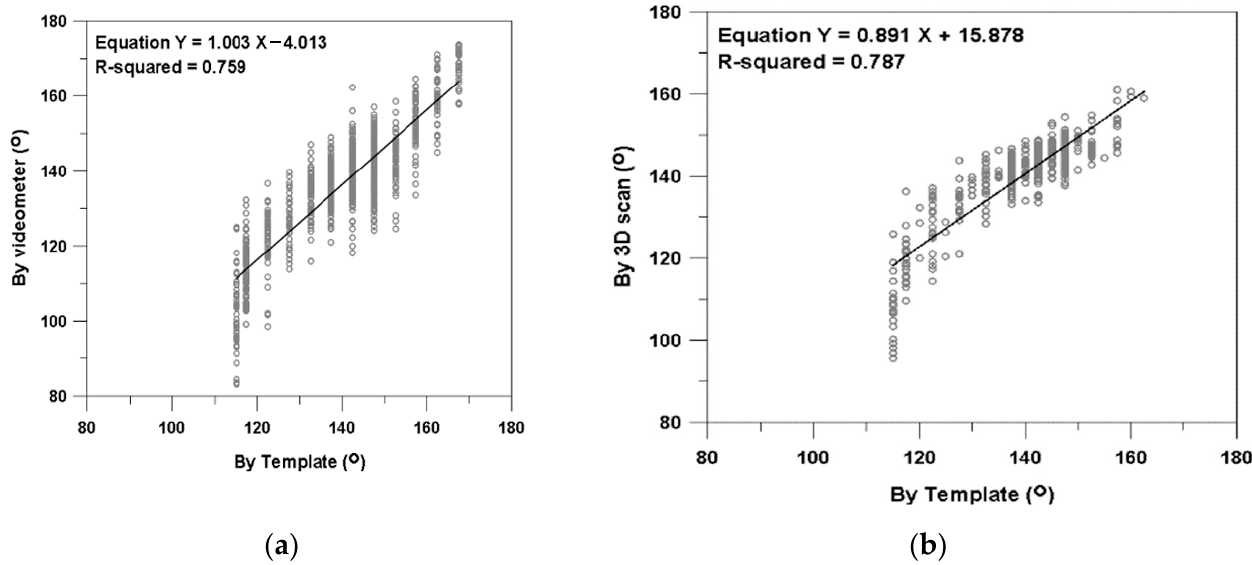
Figure 22. Correlation for each measuring method of the toe angle: ( a ) videometer; ( b ) 3D scan.